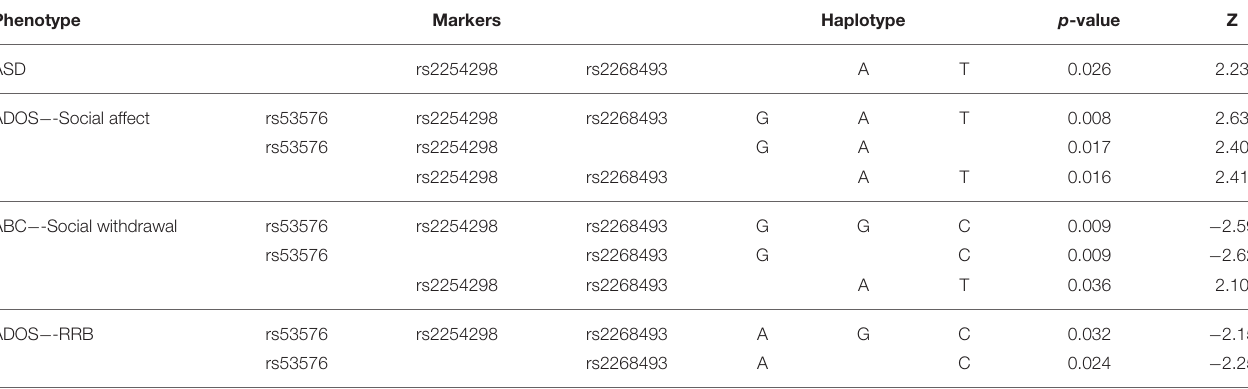
TABLE 3 | Haplotype analysis using three markers from OXTR